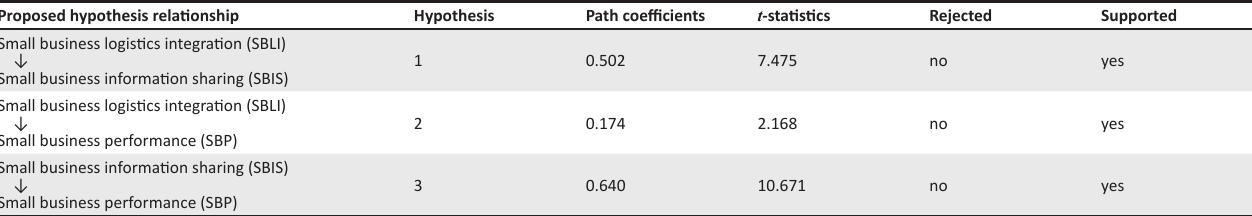
FIGURE 2: Measurement and structural model results. TABLE 4: Results of structural equation model analysis. Proposed hypothesis